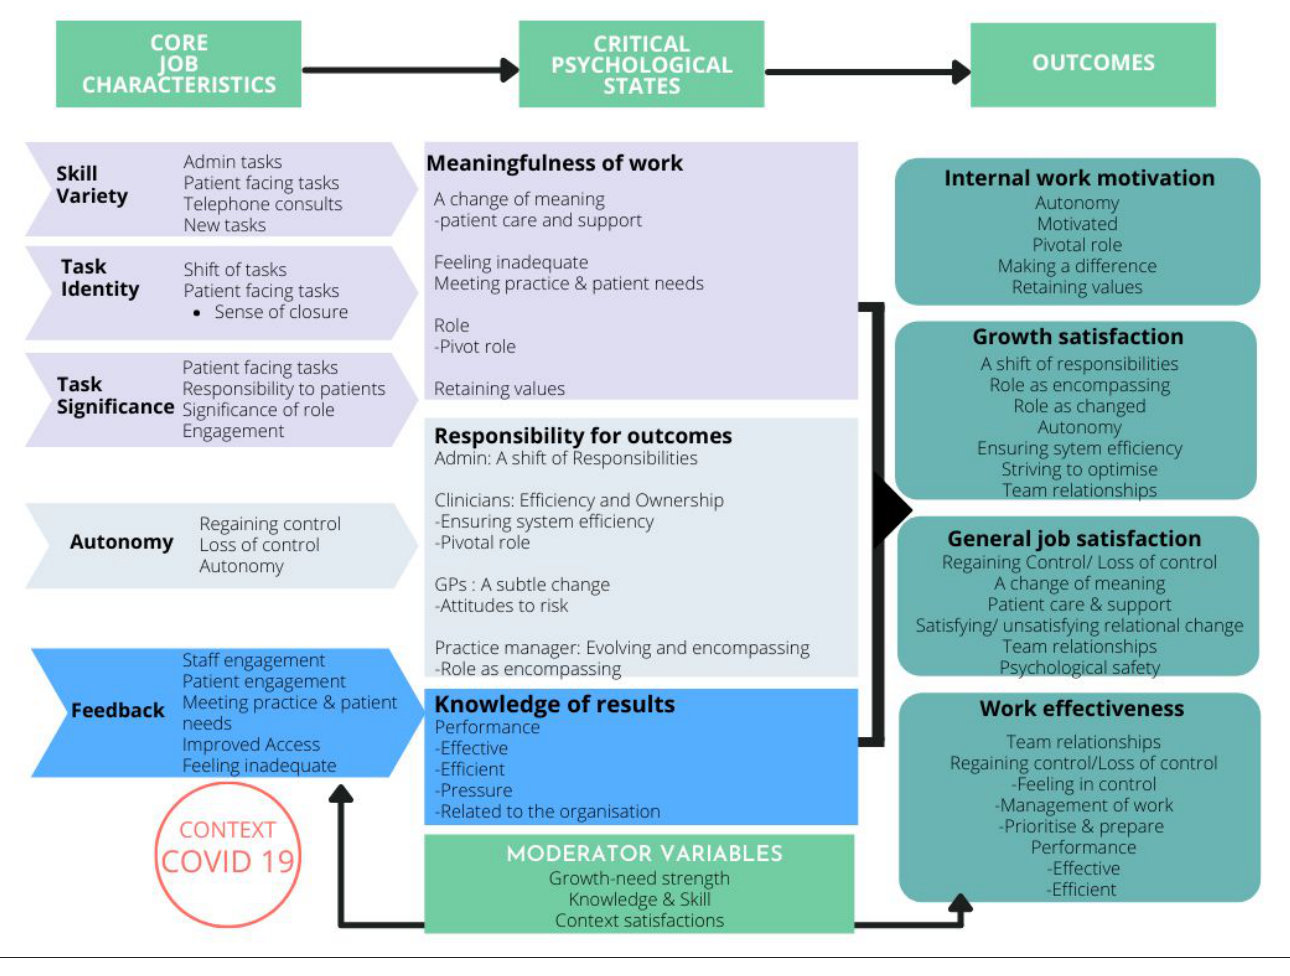
Figure 2 Findings mapped to Job Characteristics